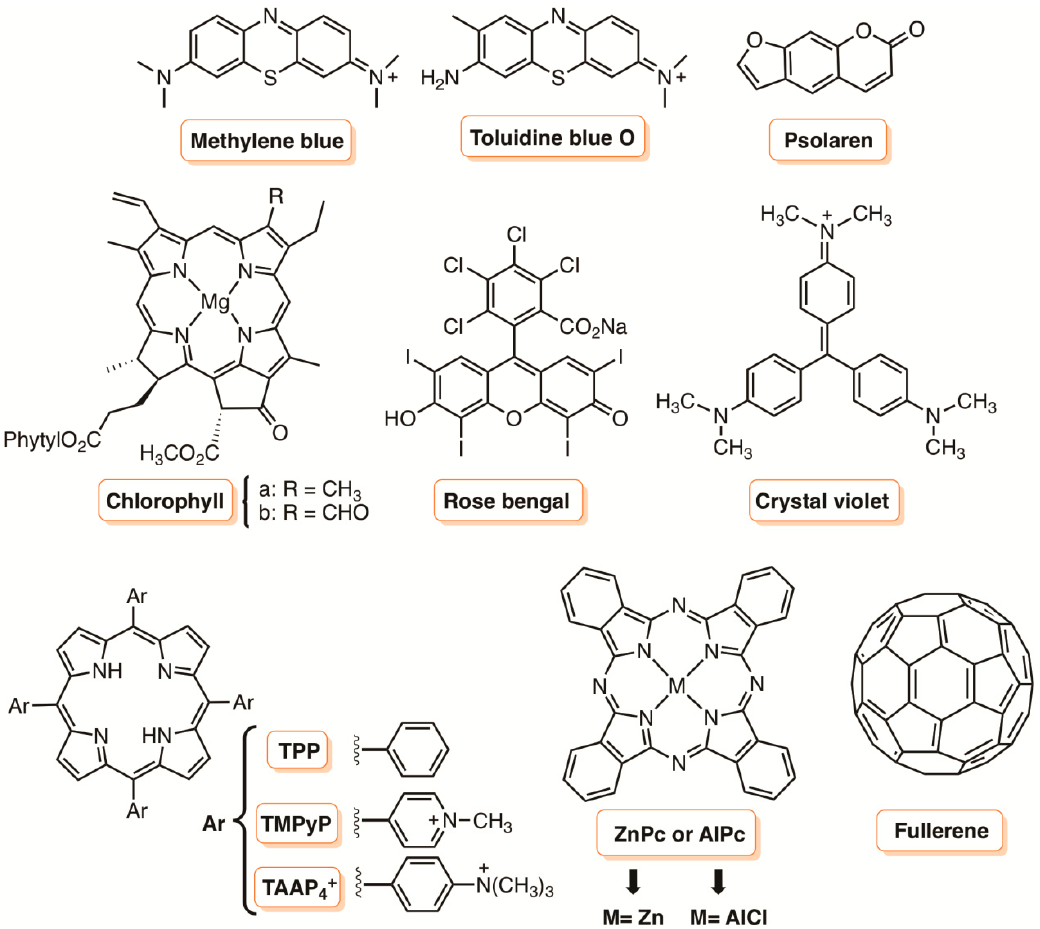
Figure 2. Structures of cores and some natural and synthetic PSs commonly used as antimicrobial agents.